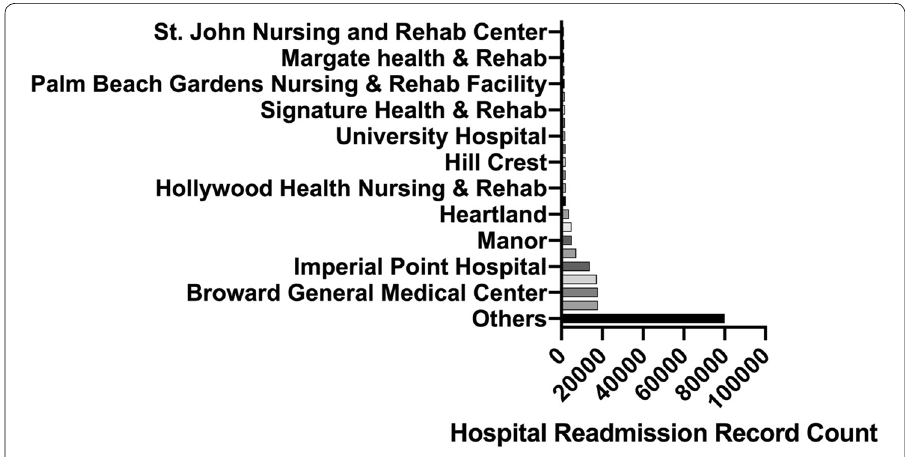
Fig. 2 Discharge summary count by hospital